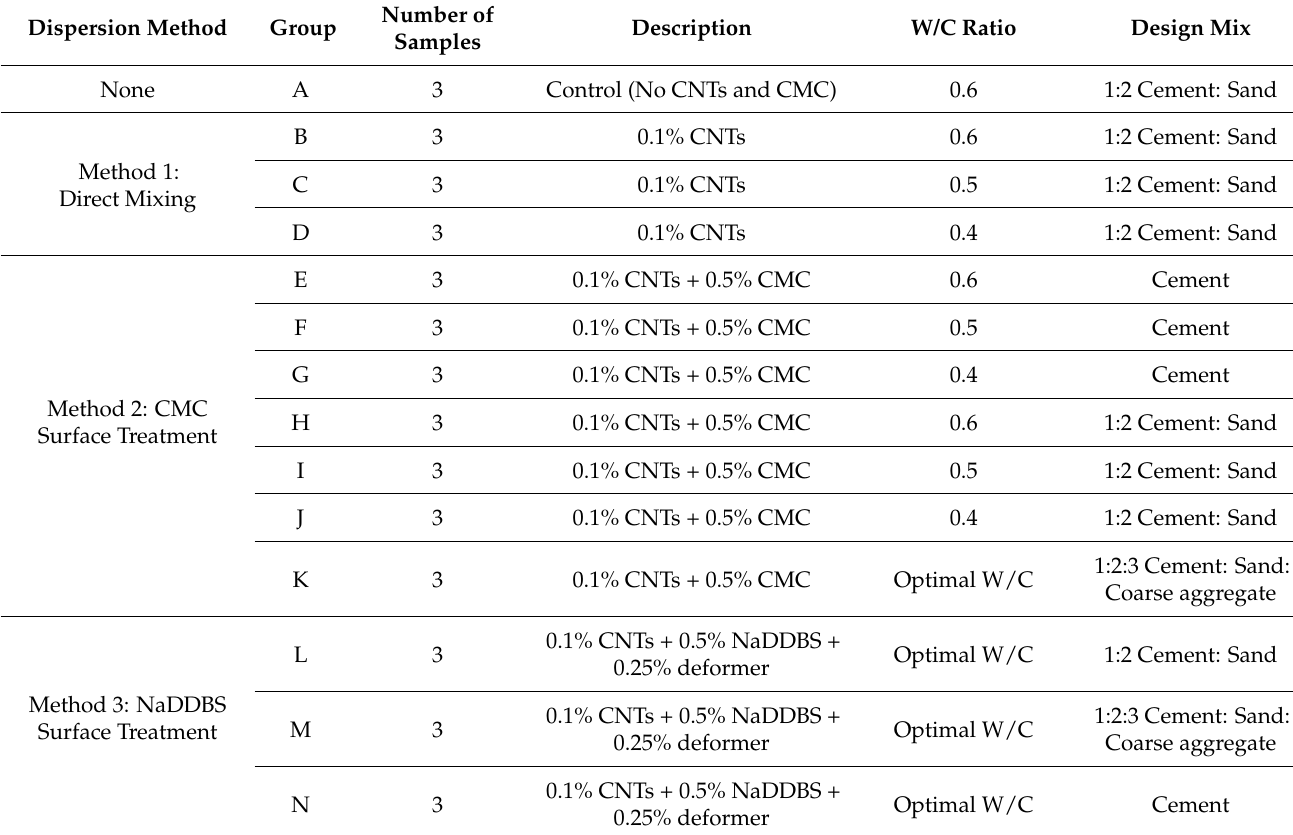
Table 2. Testing sample